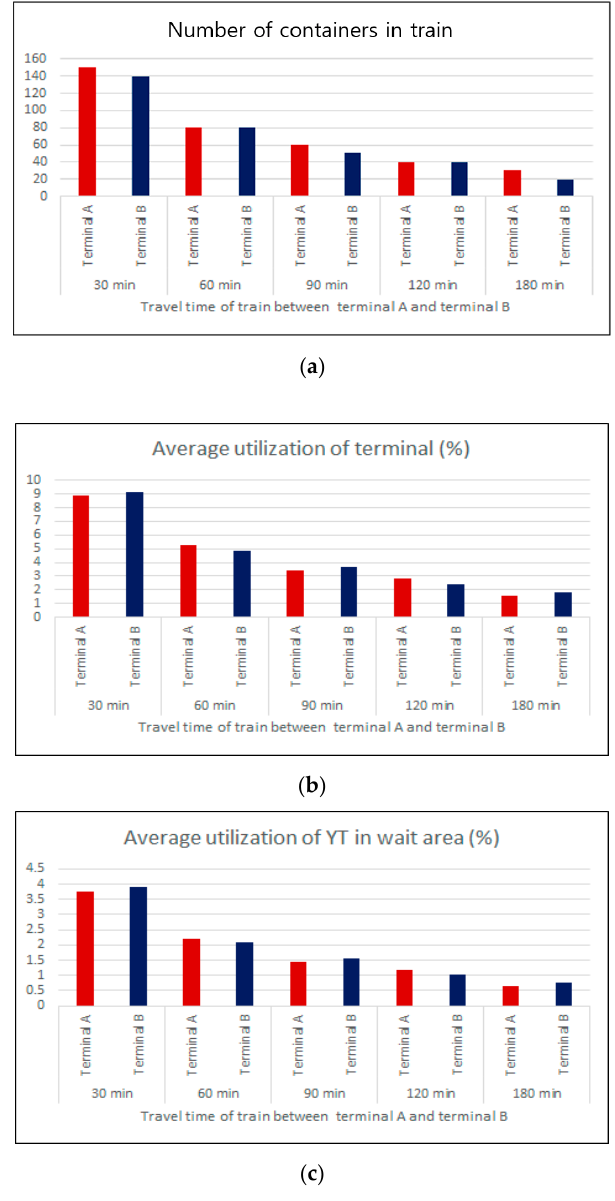
Figure 17. Simulation results for the travel time for a one-directional rail between terminals A and B for a single train. The operating time of the train was 18 h. ( a ) Number of containers on the train; ( b ) average utilization of a terminal; ( c ) average utilization of a yard tractor in the waiting area.